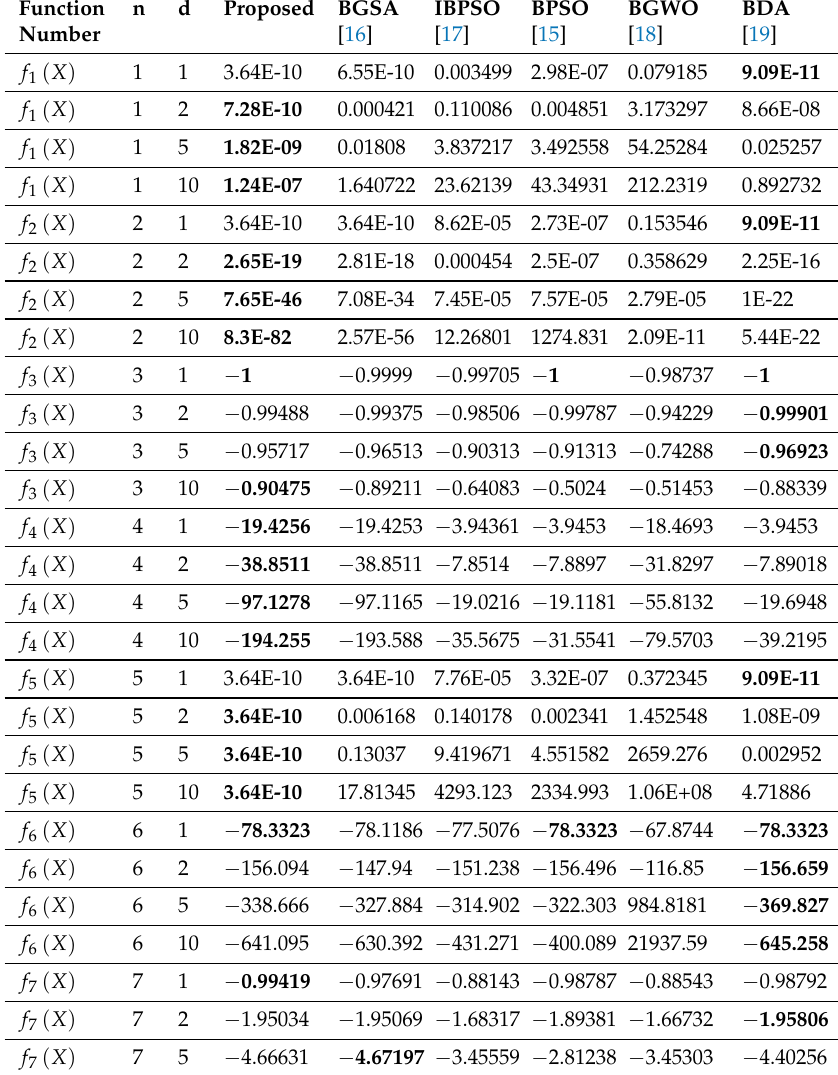
Table 2. Optimization results using various optimization algorithms for the minimization of several benchmark optimization